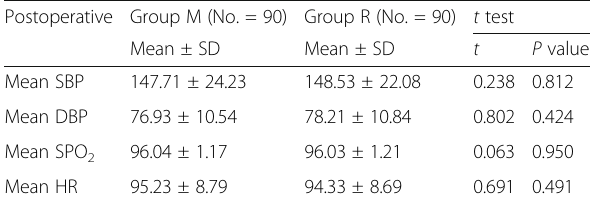
Table 3 The first three postoperative days haemodynamic parameters